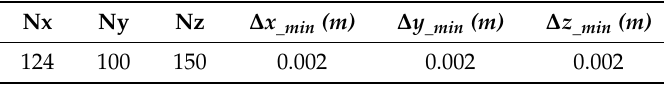
Table 5. Characteristic parameters of the computational grid.